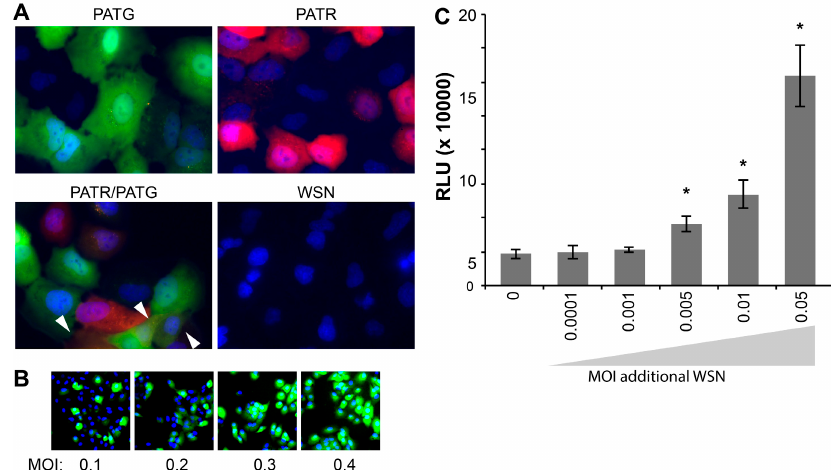
Figure 3. Influenza reporter viruses detect infection, co ‐ infection, “semi ‐ infection” and multiplicity reactivation. Live cell imaging of viral gene expression in infected cells. ( A ) A549 cells were infected with PATG, PATR, WSN or co ‐ infected with PATG and PATR. Infected cells were detected by fluorescence microscopy 18–19 hours post ‐ infection (hpi) and cells were counter ‐ stained with Hoechst 33342 to detect nuclei. Co ‐ infection is indicated by the arrowheads; ( B ) A549 cells were infected with an increasing MOI of PATG. Cells were imaged to detect total cells (Hoechst 33342) and those expressing a virally encoded gene ( GFP ). All of the cells are GFP ‐ positive when only an MOI = 0.4 is used; ( C ) Multiplicity reactivation rescues viral gene expression. A total of 25,000 MDCK cells were infected in a 96 ‐ well format with PASTN at an MOI = 0.005. Where indicated, cells were also simultaneously infected with increasing amounts of WSN. A luciferase activity assay was performed 10 hpi to determine PASTN gene expression for each condition (average relative light units (RLU), Data are mean of n = 4 ± sd). Conditions with a statistically significant increase in gene expression compared to PASTN alone are marked (* p < 0.05, Student’s t ‐ test) .